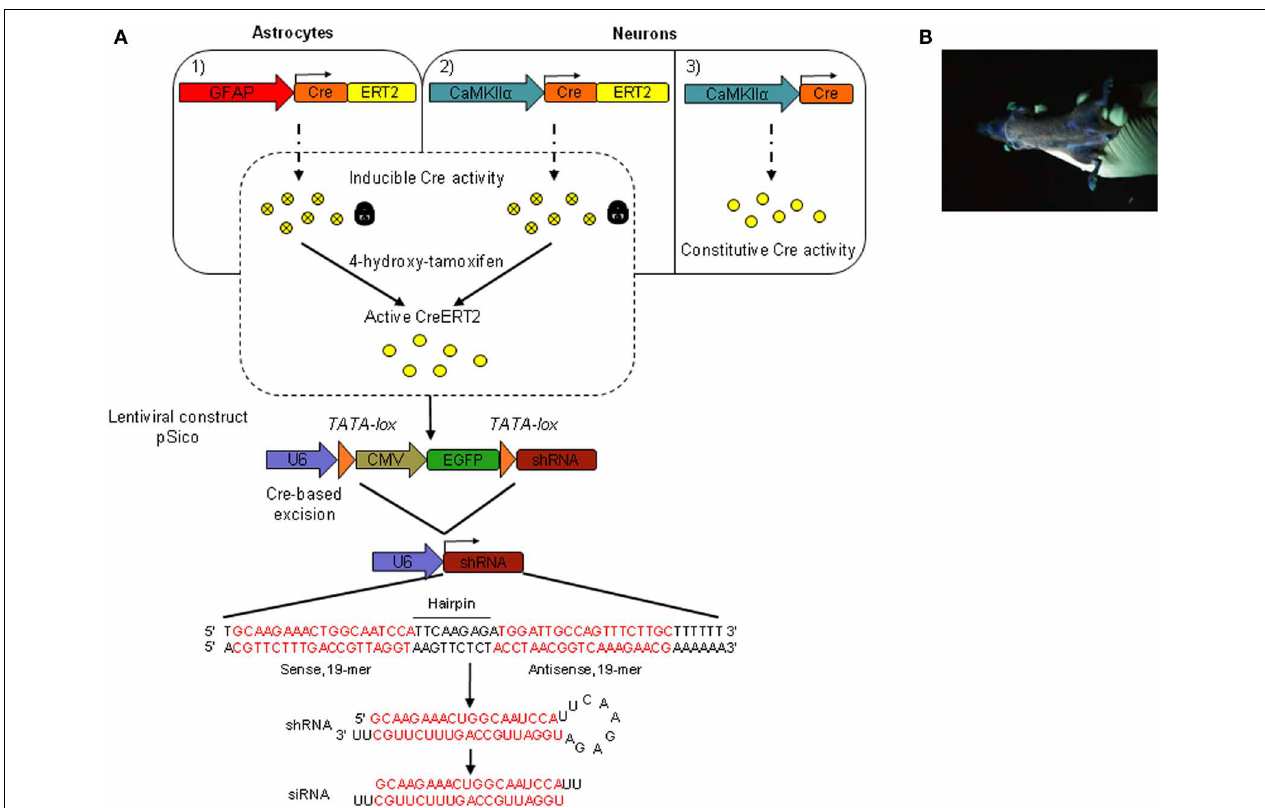
FIGURE 2 | Inducible and cell-specific gene knockdown in vivo . (A) Schematic representation of the genetic system used to achieve inducible and astrocyte- or neuron-specific shRNA expression in the adult mouse brain. pSico-shRNA3 × GFAP-CreERT2 (1) and pSico-shRNA3 × CaMKII α -CreERT2 mice (2) express a Cre recombinase fused to a mutated version of the human estrogen receptor ligand-binding domain (ERT2). CreERT2 requires 4-hydroxytamoxifen (active tamoxifen metabolite) to be active. pSico-shRNA3 × CaMKII α -Cre mice (3) express a constitutively active Cre recombinase. CreERT2/Cre expression is under the control of either the astrocyte-specific GFAP promoter (1) or the